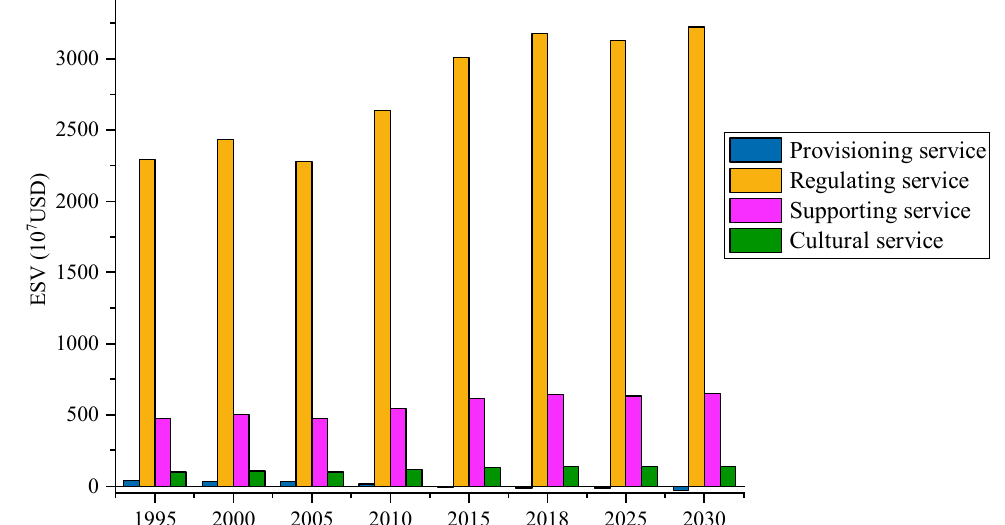
Figure 7. Changes in ESVs of different ecosystem service types from 1995 to 2030.